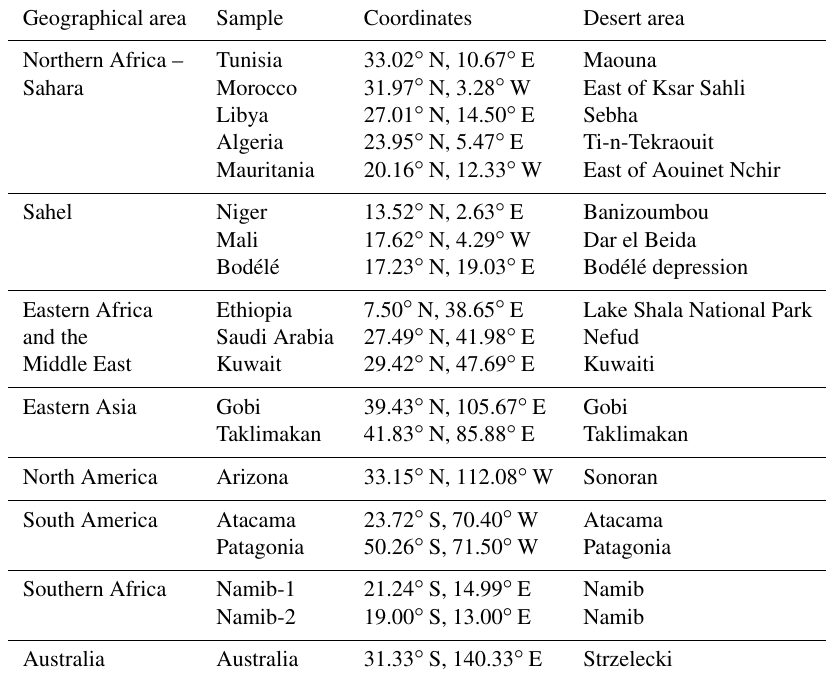
Table 2. Summary of information on the soil samples and sediments used in this